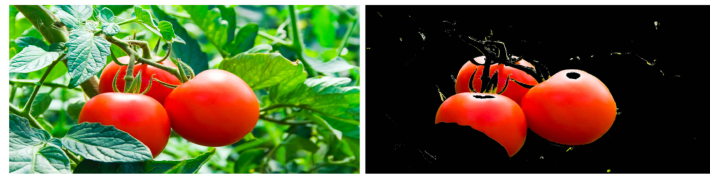
Figure 12. Original image ( left ) and Neural Network output ( right ).